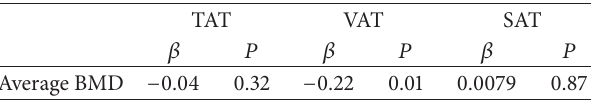
Table 4: Multiple linear regression including TAT, VAT, and SAT as independent predictors of BMD in group aged < 55, adjusting for